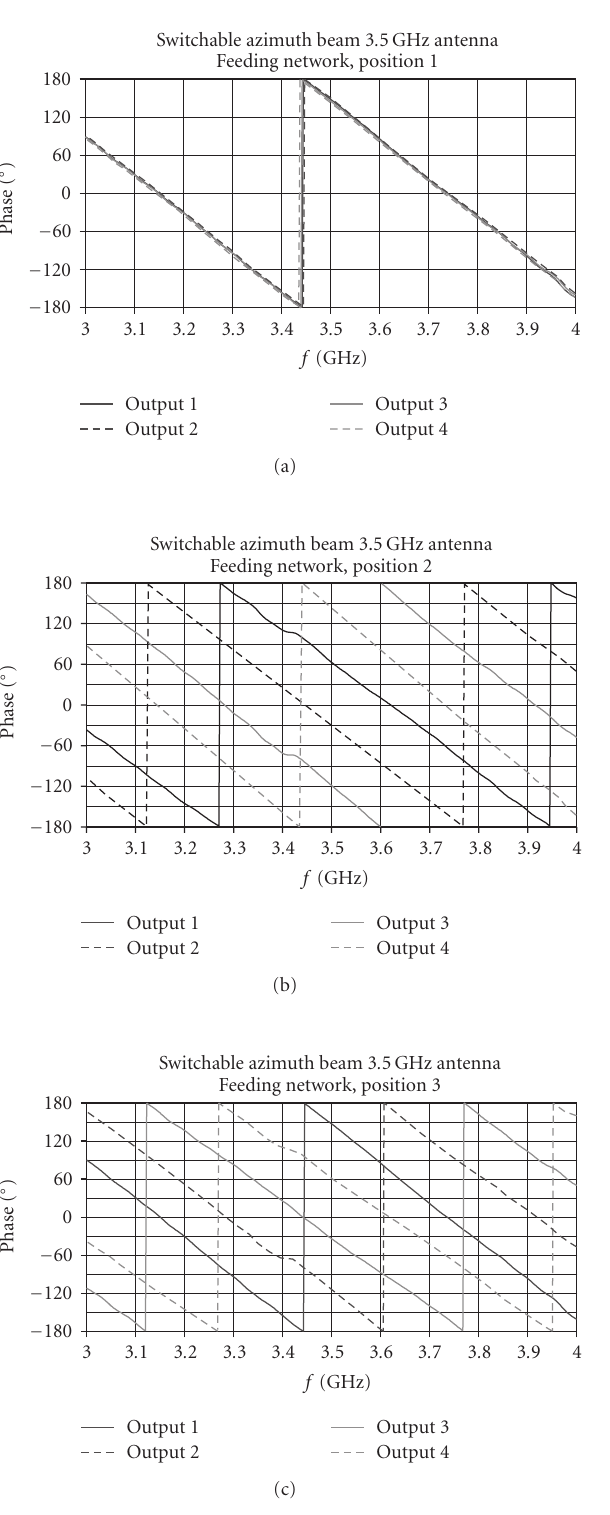
Figure 12: (a) Feed network measurement: output phases for position 1, (equal phase). (b) Feed network measurement: output phases for position 2, ( − 90 ◦ progressive phase shift). (c) Feed net- work measurement: output phases for position 3, (+90 ◦ progressive phase shift).